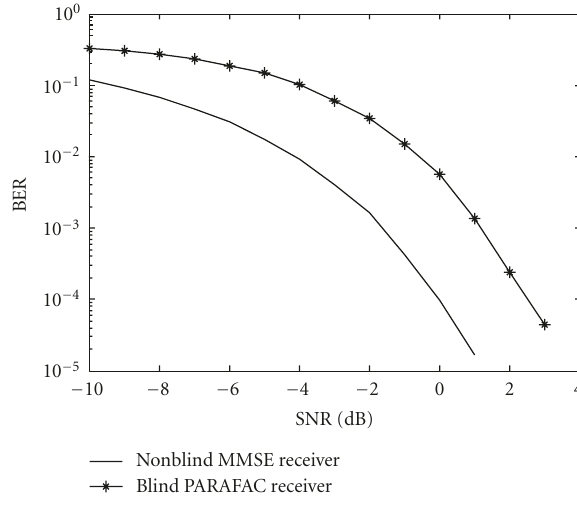
Figure 4: The algorithm performances comparison with N = 200.